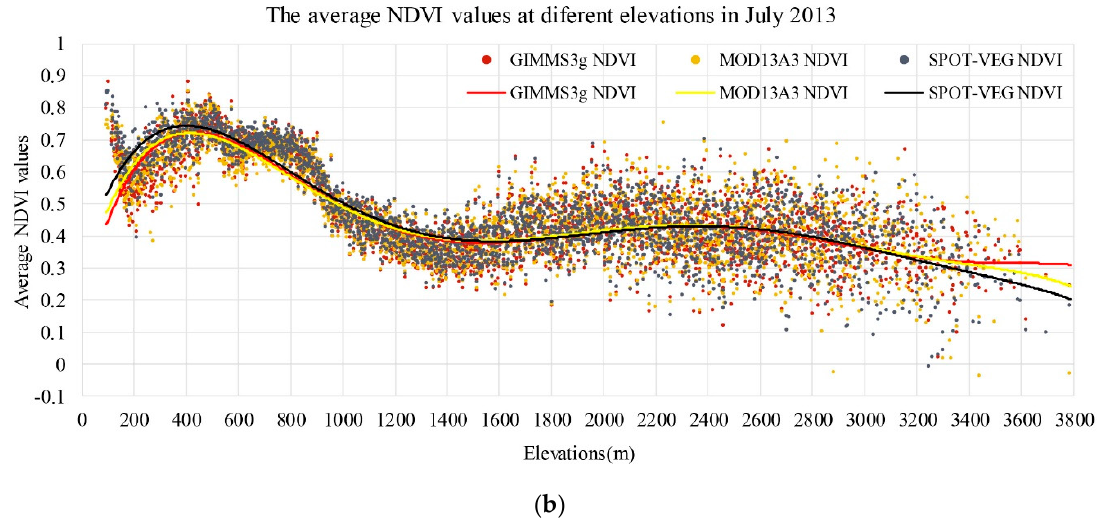
Figure 10. Scatter plots and fitting curves of average NDVI values at different elevations from 95 m to 3788 m in ( a ) January 2013 and ( b ) July 2013.